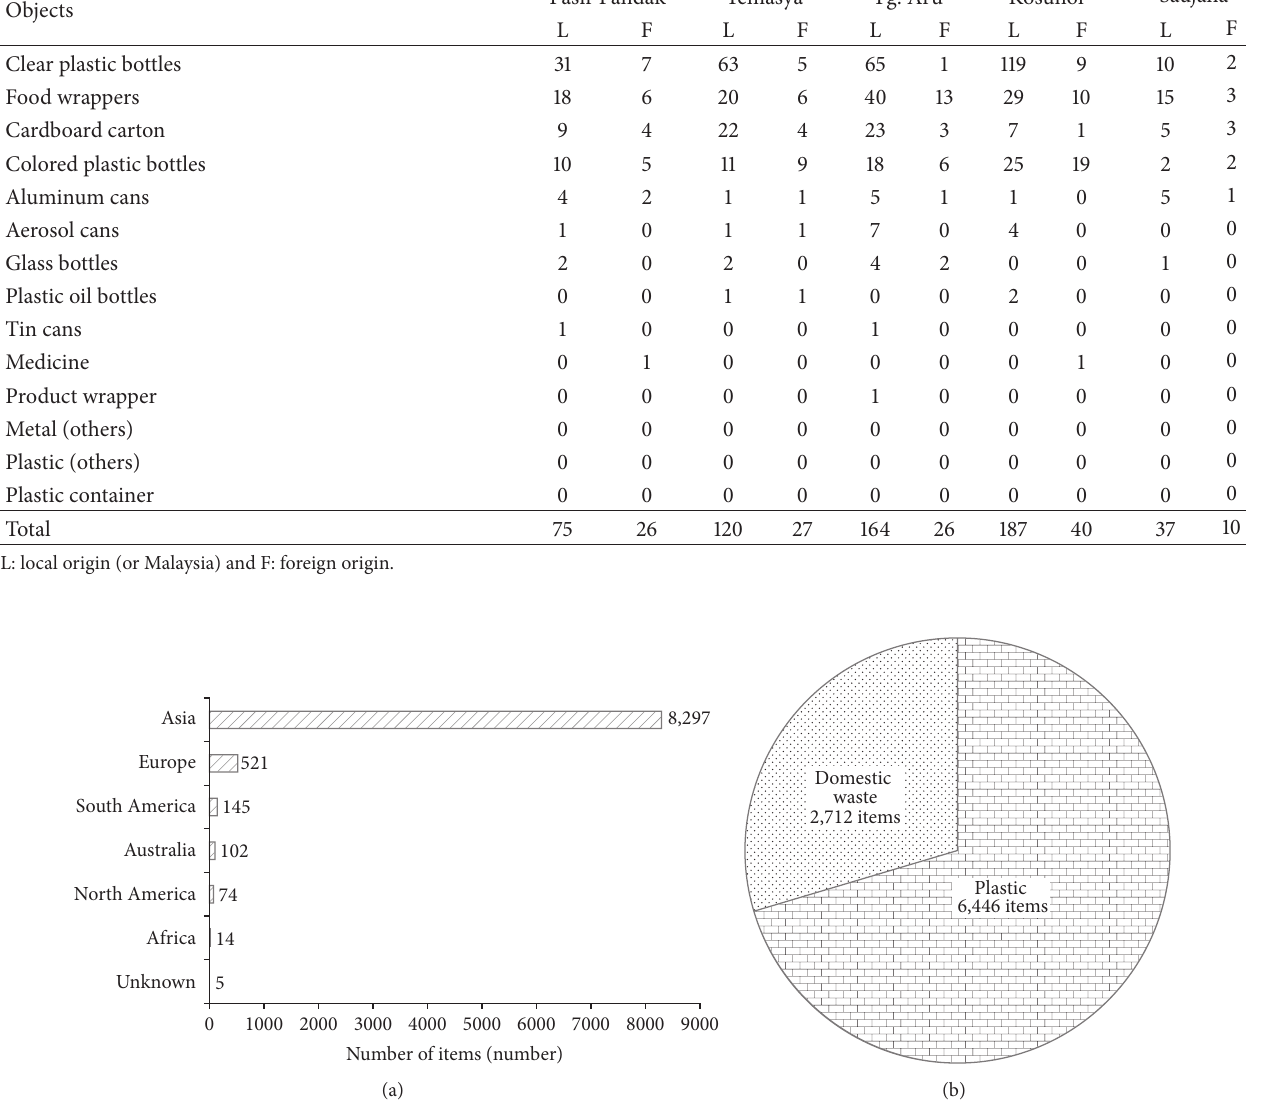
Figure 3: Total labeled items (number, items ) found at ship surveys according to (a) continents and (b) debris category.